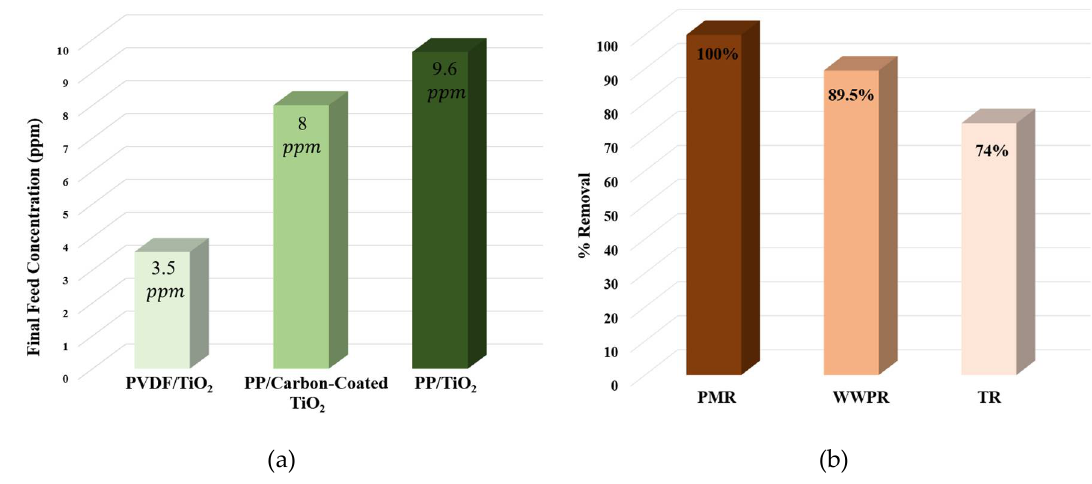
Figure 17. Comparison between: ( a ) PVDF / TiO 2 , polypropylene (PP) / carbon-coated TiO 2 , and PP / TiO 2